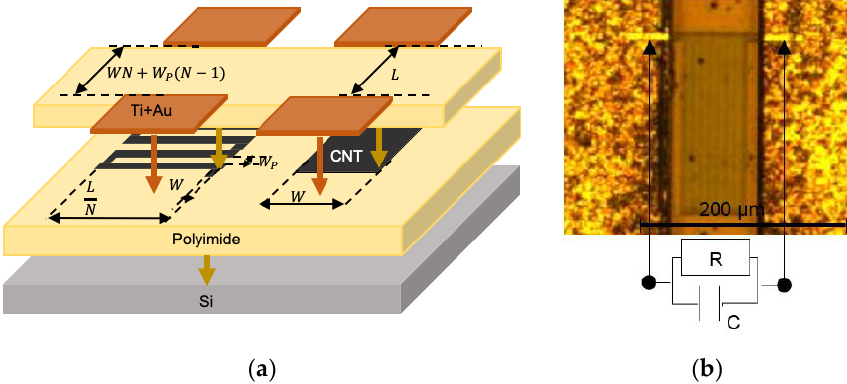
Figure 1. Carbon nanotube sensors. ( a ) Magnified view of the temperature-moisture sensitive layer. ( b ) Optical microscopic picture and equivalent electrical circuit of the sensor.